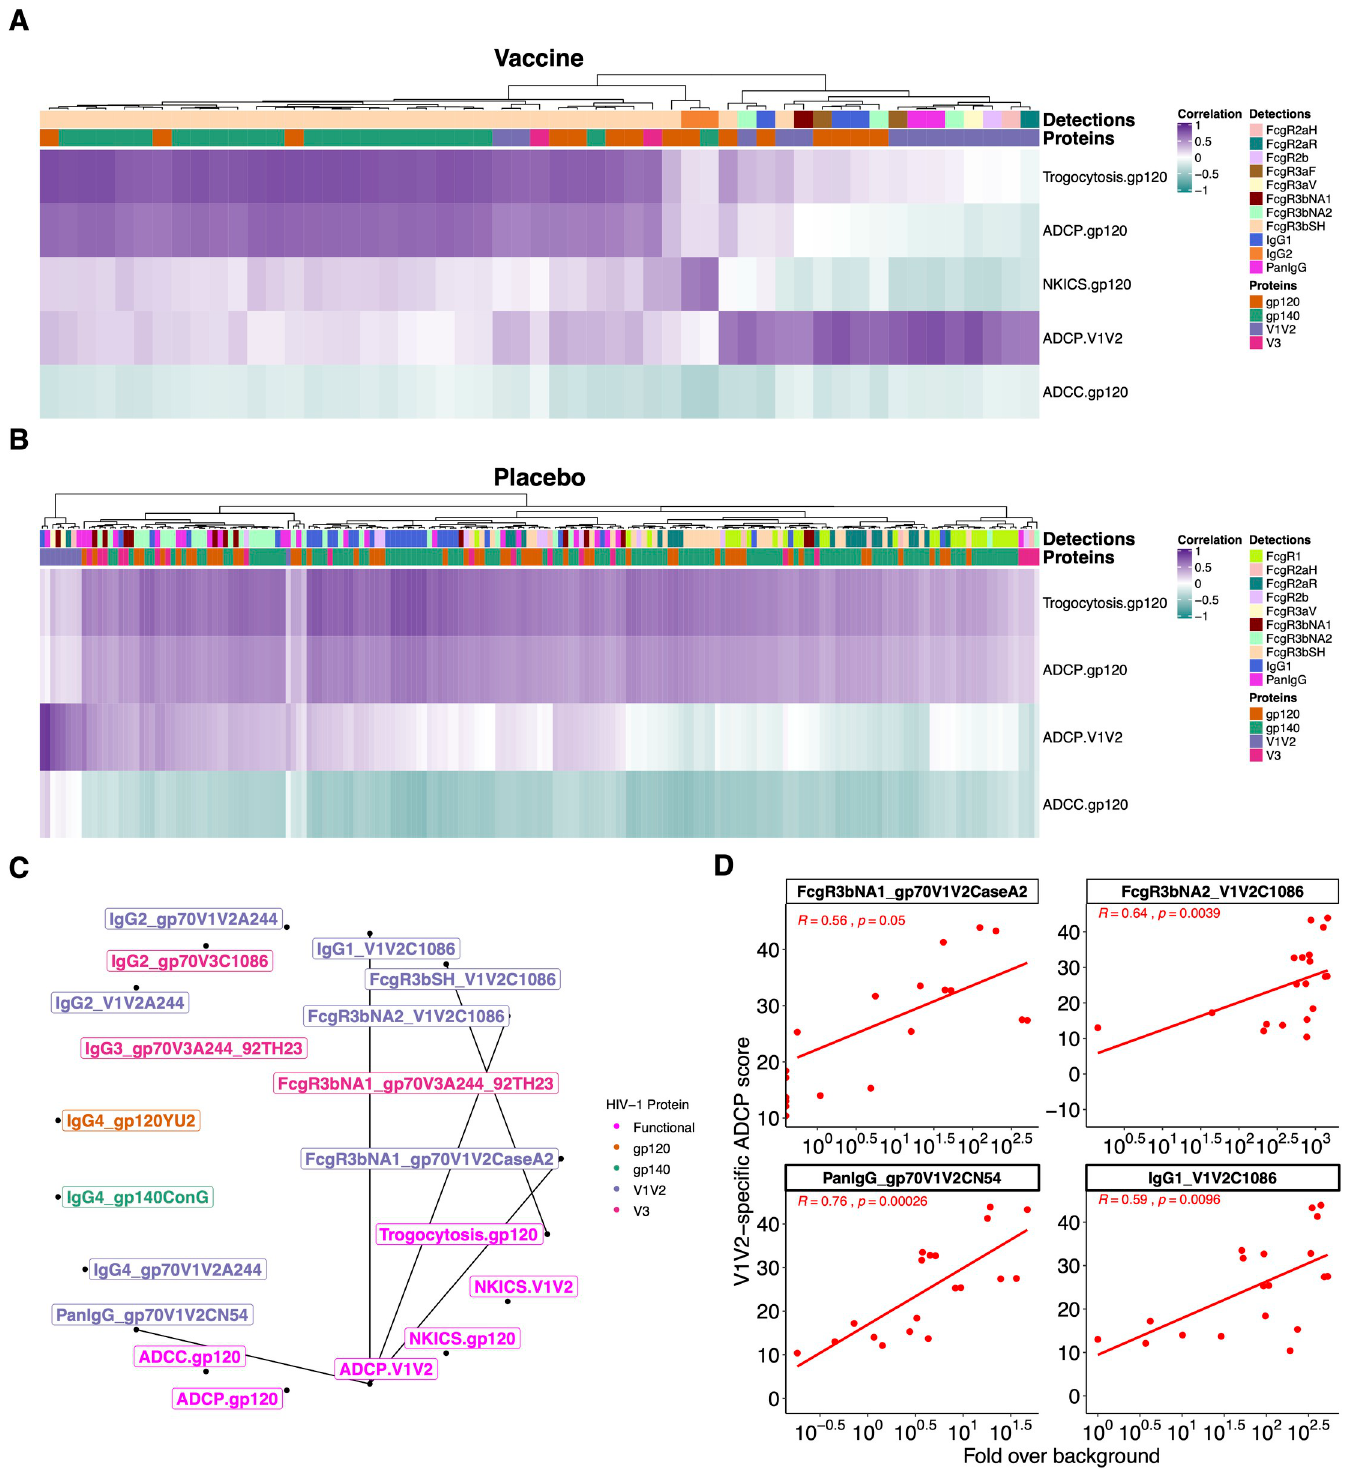
Fig 7. V1V2 responses were associated with V1V2-specific ADCP responses in RV144 vaccinees. Canonical sPLS model highlighted Ab binding features which covaried with the Fc effector functions for vaccine (A) and placebo (B) recipients. Colors show the direction of the associations: positive (dark purple) and inverse (dark cyan). (C) Correlation network highlighting the vaccine RF-selected predictive features that correlated with Fc effector functions. (D) Scatter plots showing significant Spearman correlations between V1V2-specific ADCP and binding responses in vaccine recipients.